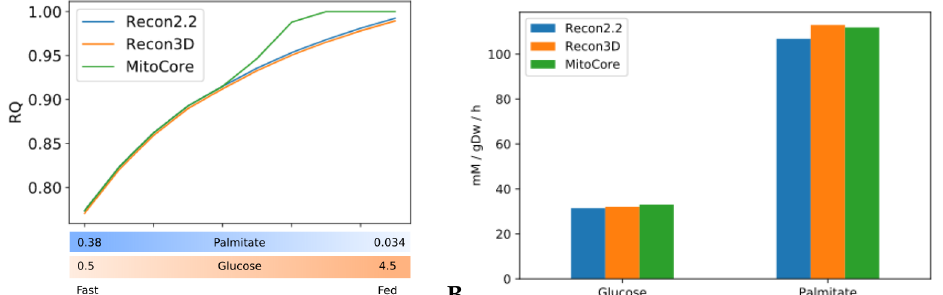
Figure 2. Simulations of fast to fed transition highlight heterogeneity of model predictions. Validation of our of the fast-to fed transition. ( A ) RQ values predicted by three human constraint-based models (Recon2.2, Recon3D and MitoCore) during the fast to fed transition with the objective function ATPH left unconstrained (upper bound ATPH = 1000 mM/gDw/h). X axis: upper bound values for palmitate and glucose exchange reactions during the fast to fed transition (in mM/gDw/h). ( B ) ATP yields for glucose and palmitate across the three models.